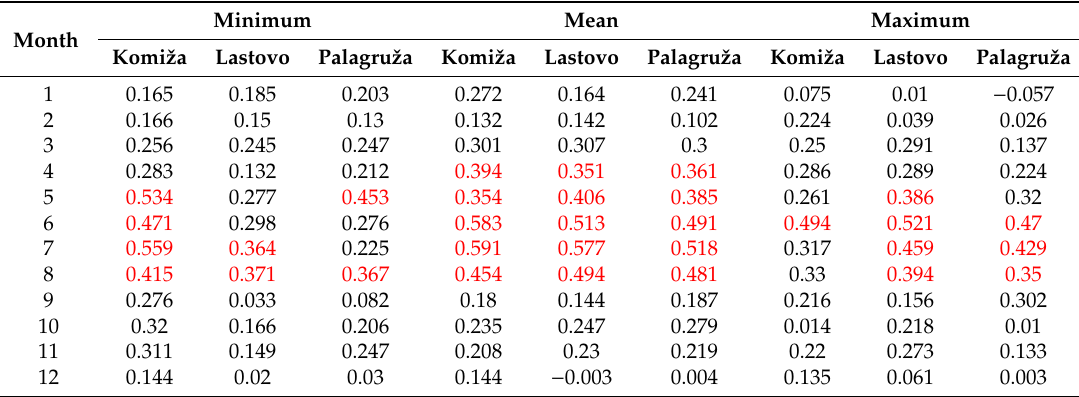
Table 4. The linear correlation coe ffi cient r calculated from the contemporaneous dataset of the minimum, mean, and maximum monthly air temperature. The values in red correspond to the months that showed statistically significant results of the SROC test ( p <